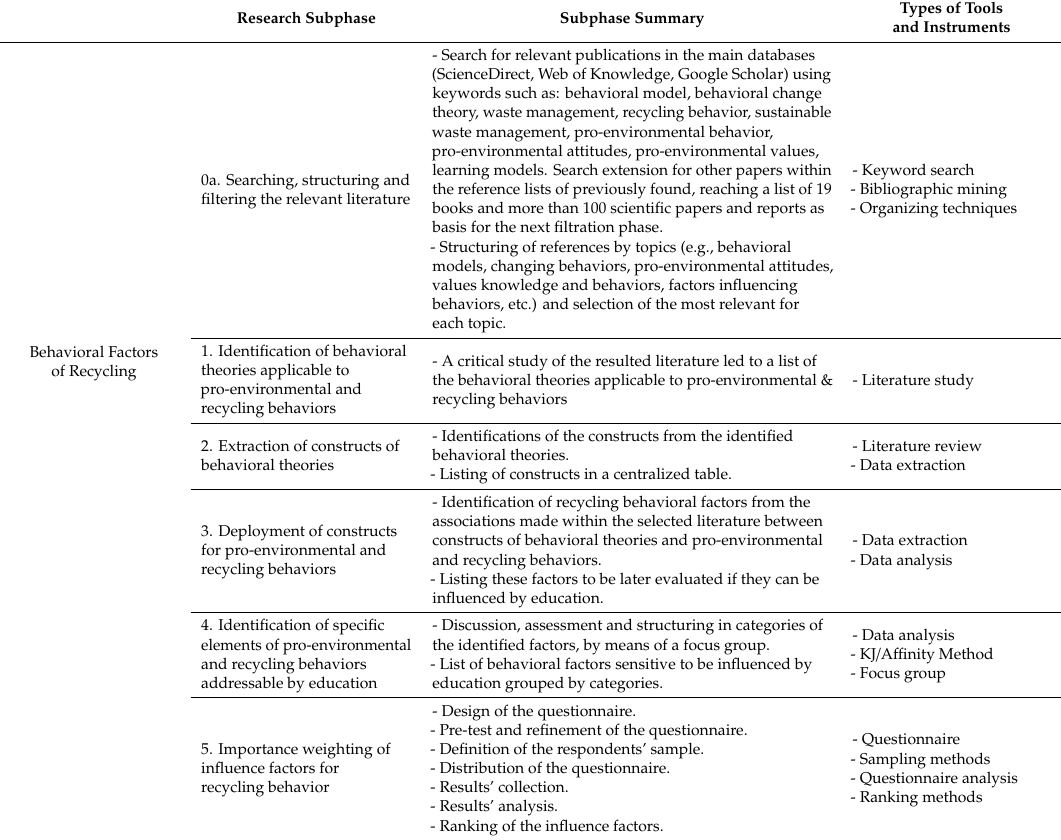
Table 1. Summary of research subphases and tools &